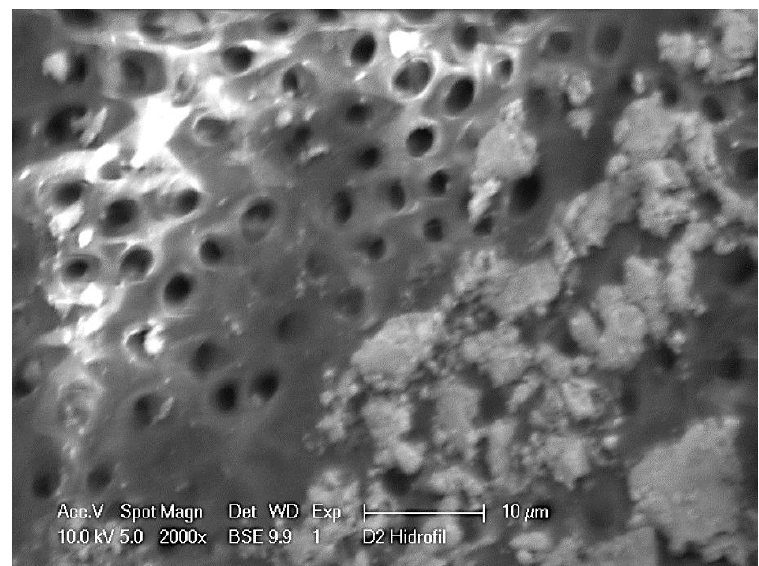
Figure 2. Scanning electron microscopy (SEM) of E. faecalis biofilm formation in the root canal. At the left of the image, we can observe the clean dentin wall of the root canal with the access of the dentinal tubules. On the right, individual bacteria and biofilm formation on the surface of the dentin wall. Images were taken 2 weeks after inoculation of the dental material with the bacteria. Access to the area was achieved by a clean cut of the tooth. Image characteristics are indicated within the image.